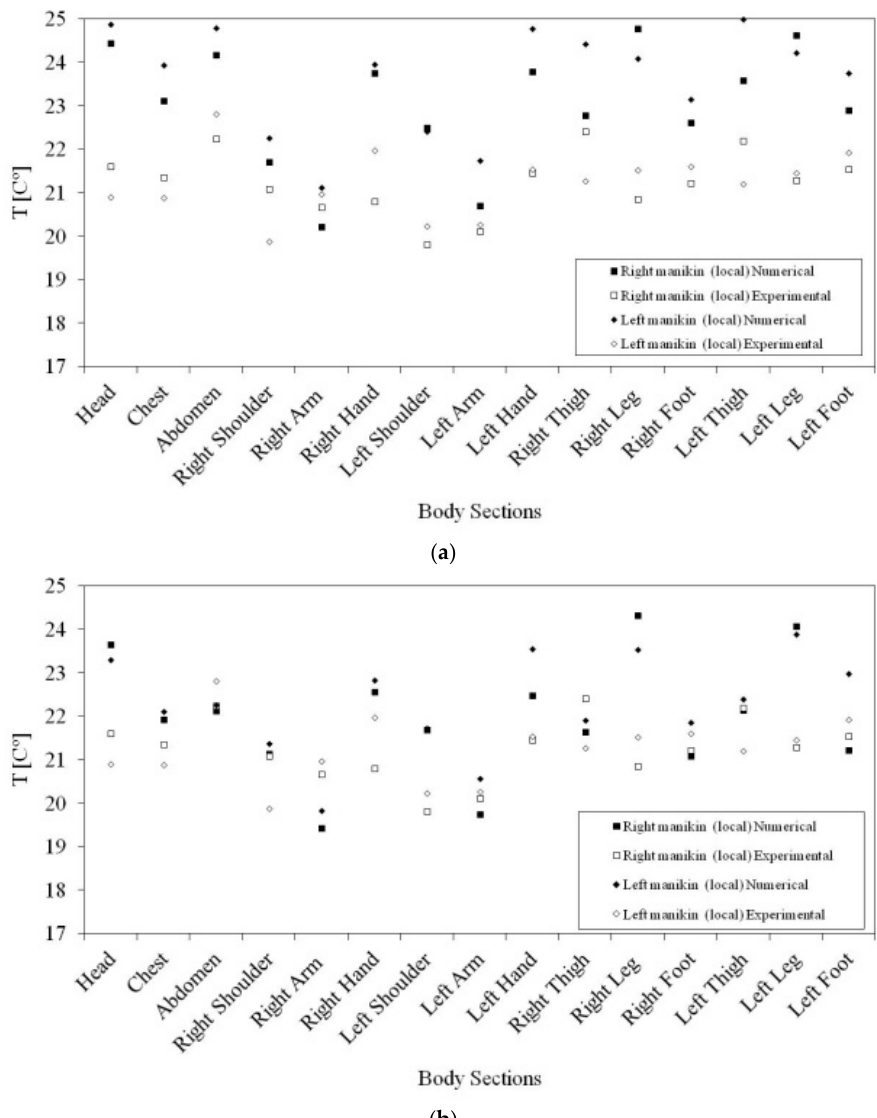
Figure 7. Air temperature values around the occupants seated on the right and left side, numerically calculated and experimentally measured. In ( a ), the k-epsilon turbulence model is used, and in ( b ), the RNG turbulence model is applied.